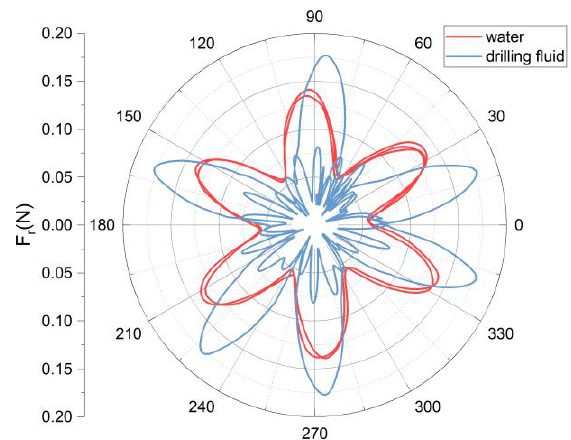
Figure 12. Polar diagram of the radial force on the impeller for the different media fluids.